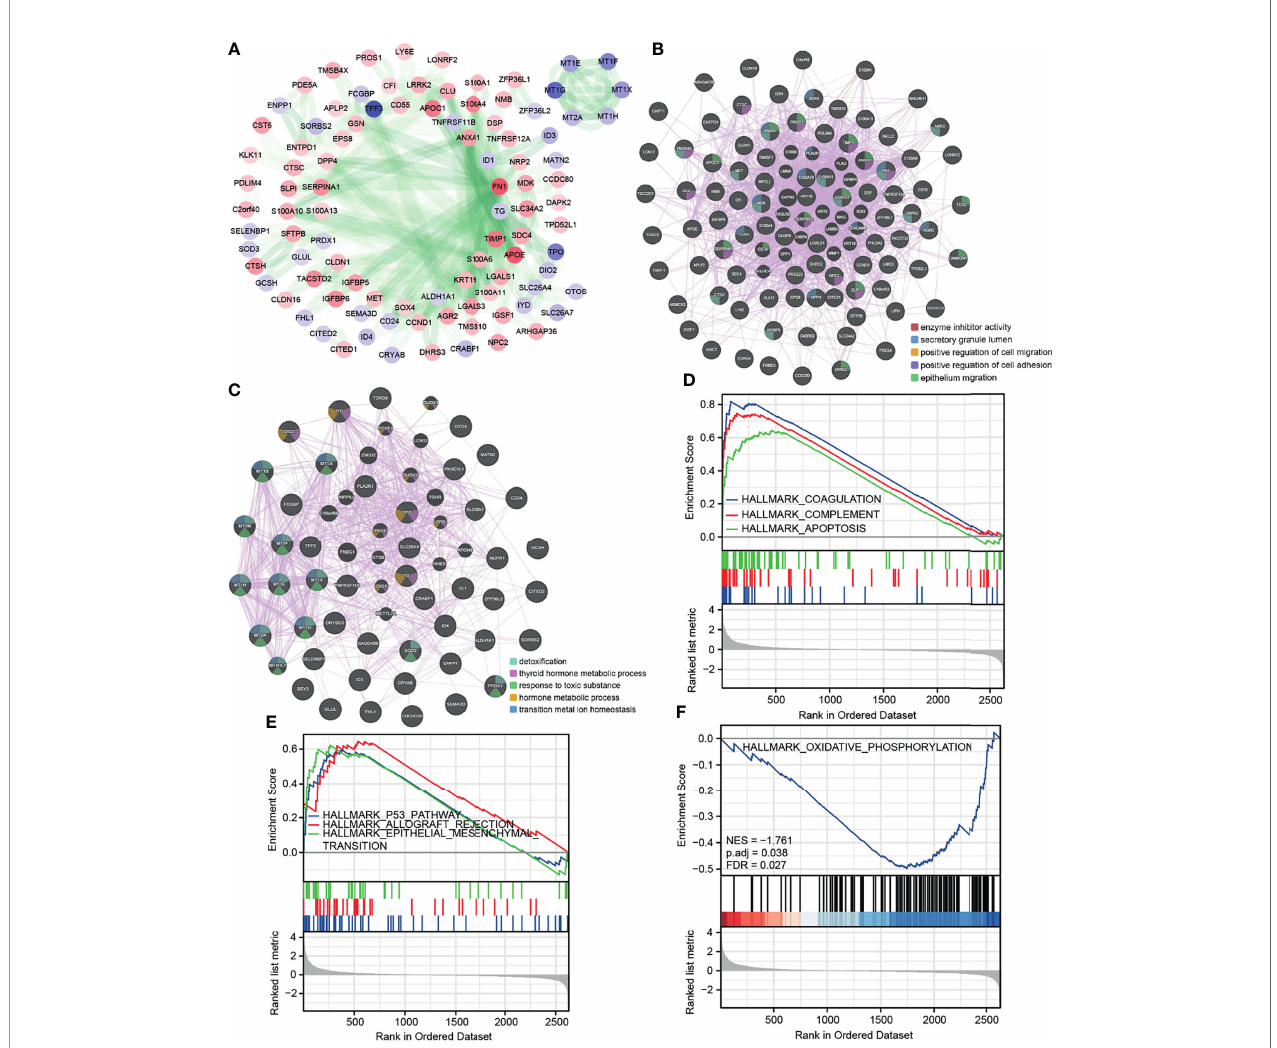
FIGURE 2 | Protein interaction network and GSEA enrichment analysis of DEGs. (A) PPI of the DEGs in STRING database. (B, C) PPI and functional enrichment analysis for upregulated and downregulated DEGs in GENEMANIA database, respectively. (D, E) GSEA analysis HALLMARK pathway (upregulated in tumor cells). (F) GSEA analysis HALLMARK pathway (upregulated in normal